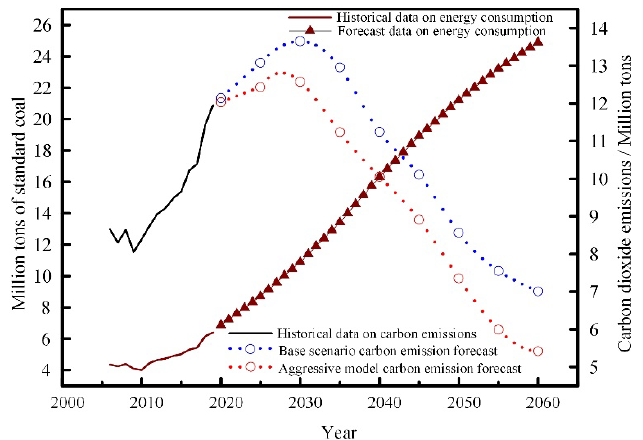
Figure 11. Comparative carbon emissions from rural productive energy consumption under differ- ent models.